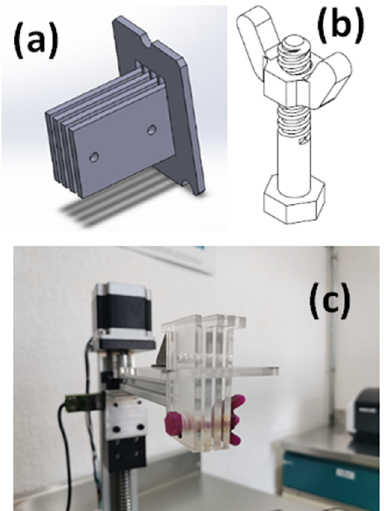
Figure 5. Clamping mechanism for glass substrates: acrylic plates ( a ), screw ( b ), substrate holder ( c ).